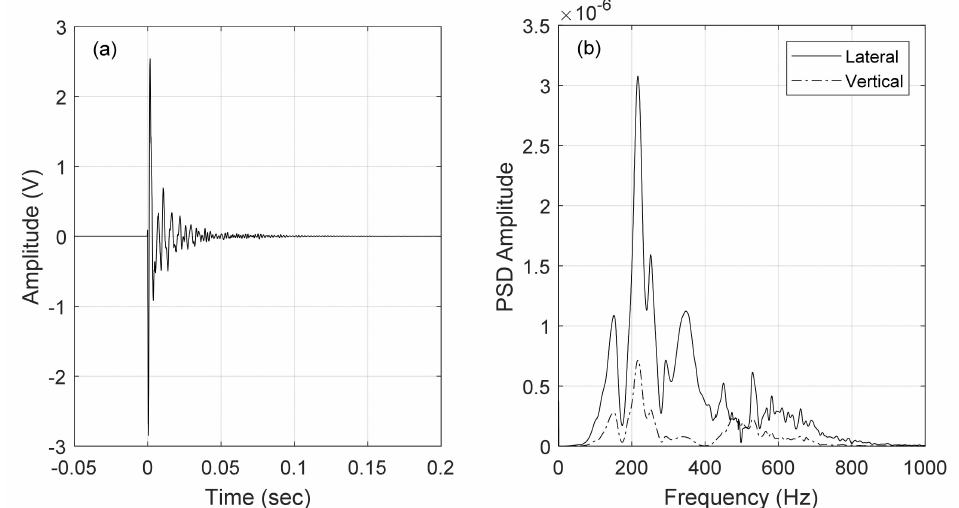
Figure 10. ( a ) Typical time-series associated with the lateral displacement and recorded by the accelerometers on the rail above the cross-tie. ( b ) Corresponding Power Spectral Density overlapped to the PSD of the vertical direction.